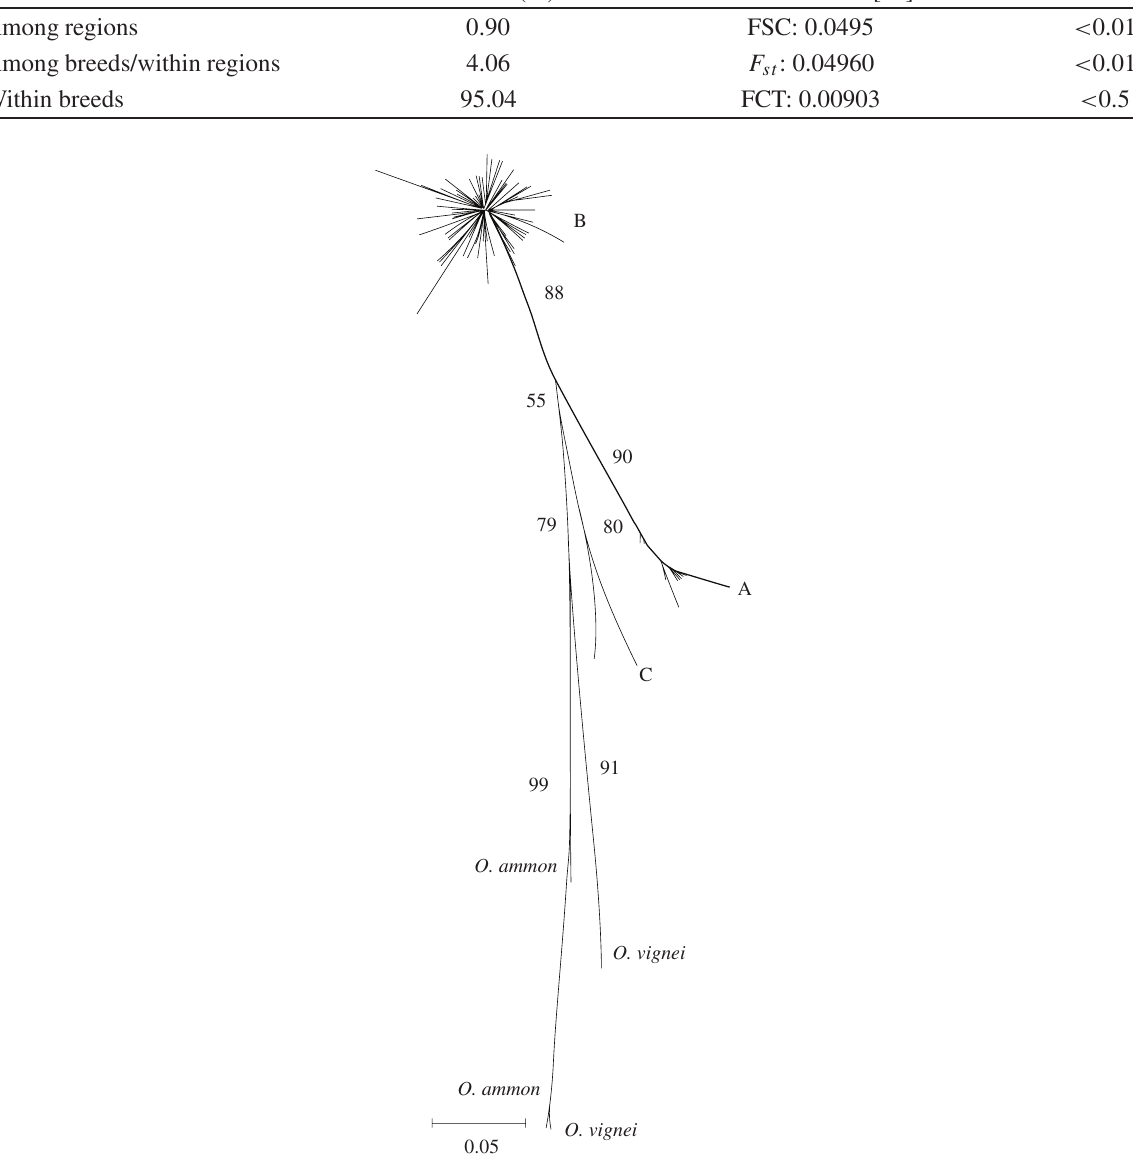
FIGURE 1: Neighbour-joining tree based on the 154 mtDNA haplotypes, showing differences among haplogroups and wild sheep (outgroup). Numbers indicate the percentage bootstrap support (10,000 resam-